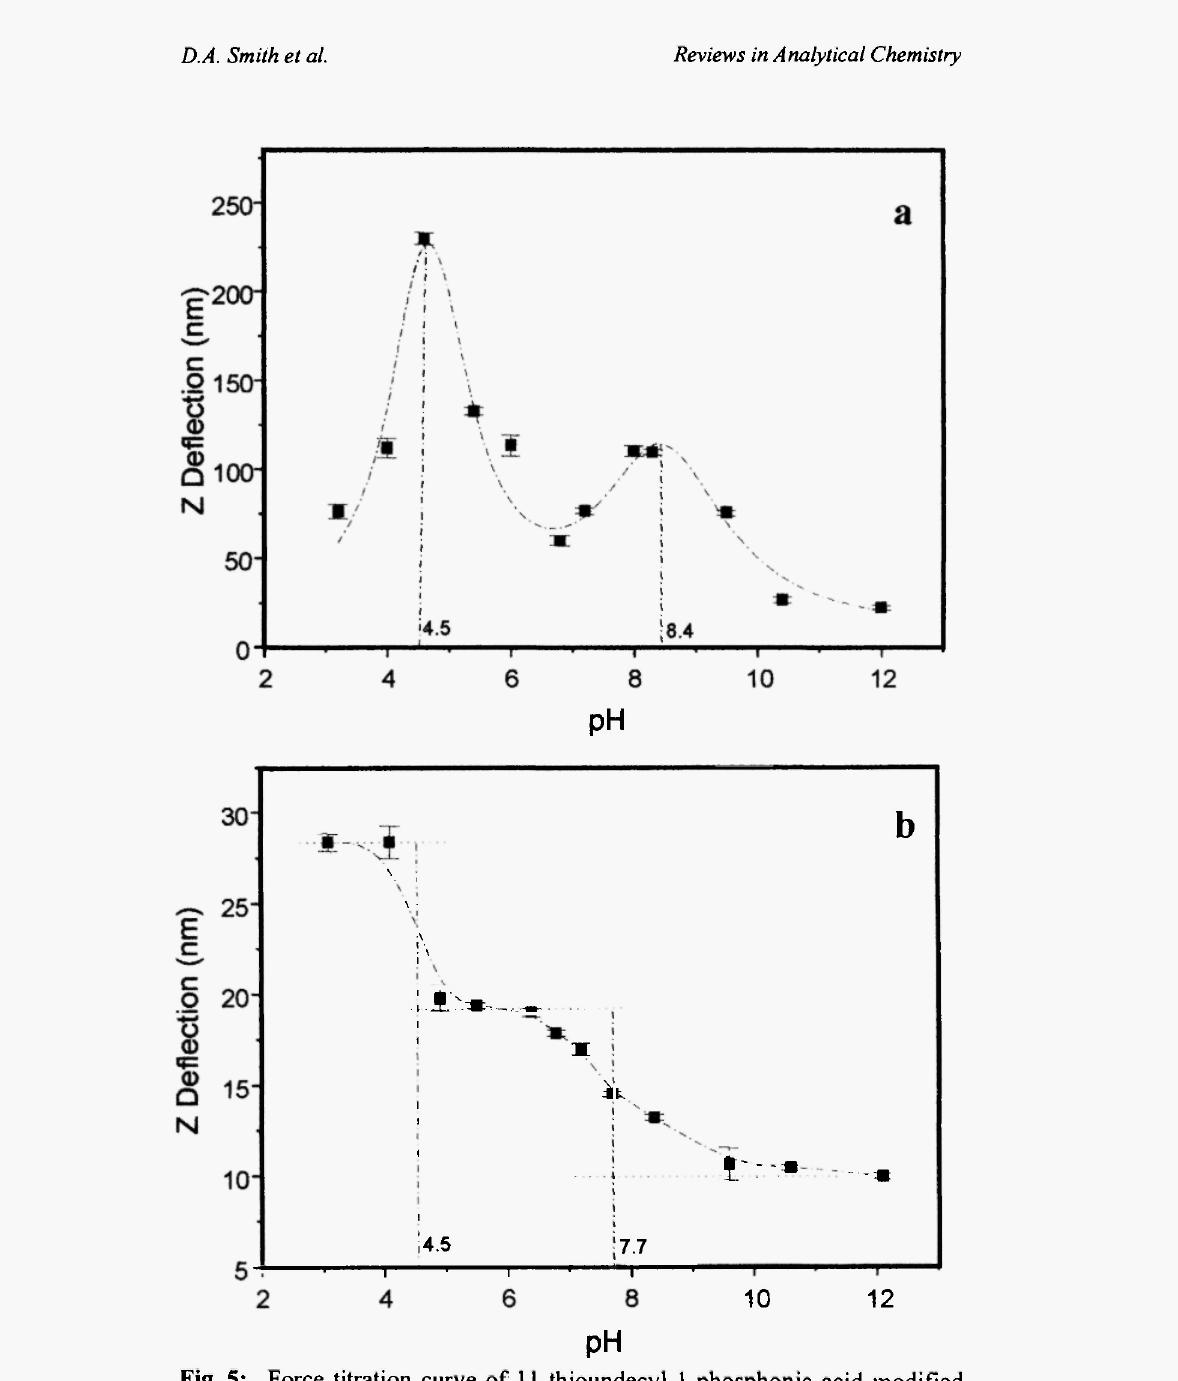
Fig. 5: Force titration curve of 11-thioundecyl-l-phosphonic acid modified tip and substrate in phosphate buffer at ionic strengths a) ΙΟ" 4 Μ and b) 10"'